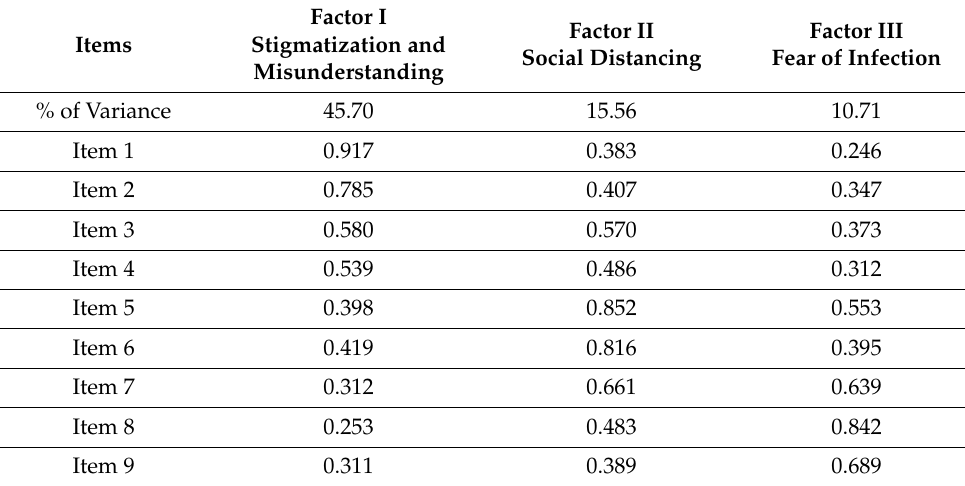
Table 1. Factor structure of the nurses’ pandemic-related experiences questionnaire.